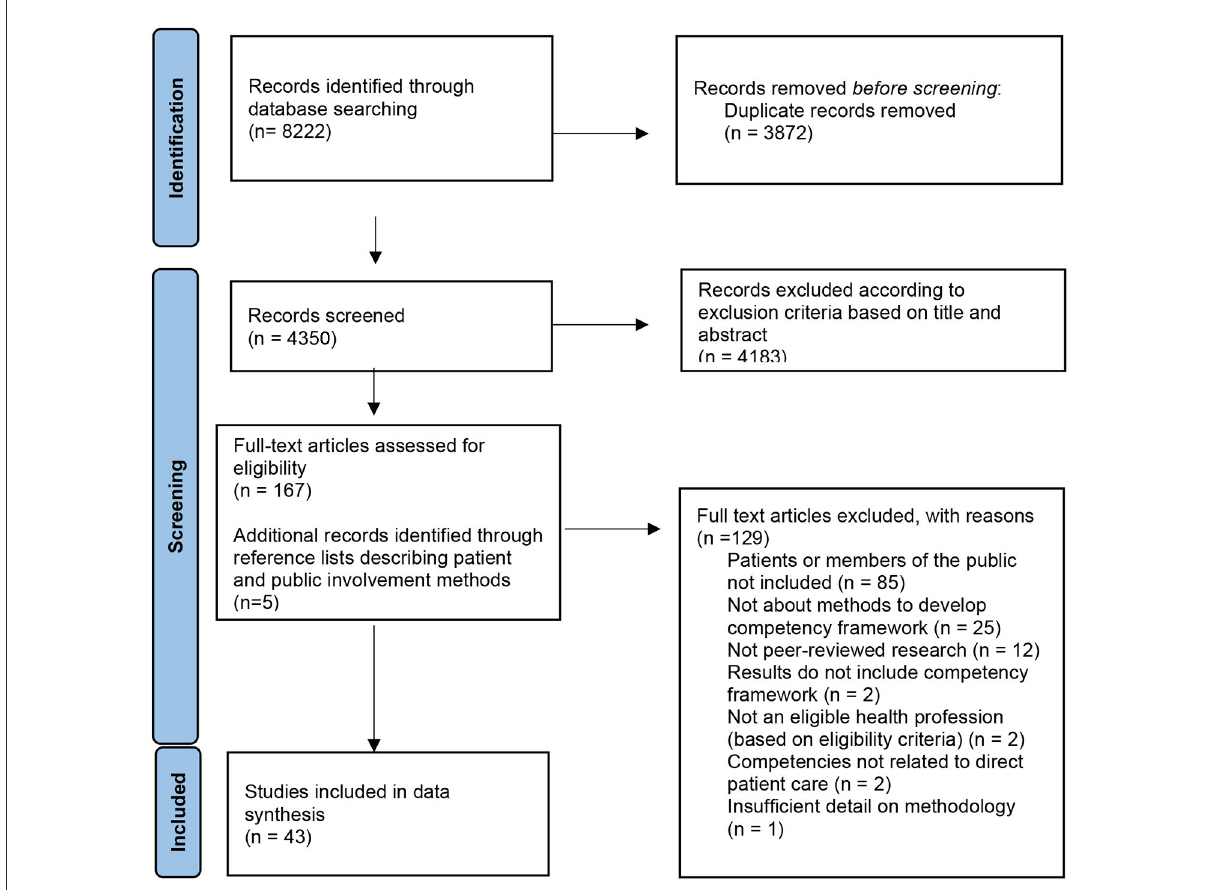
FIGURE1 PRISMA flow diagram for identification of studies including patients and the public in competency framework development for health